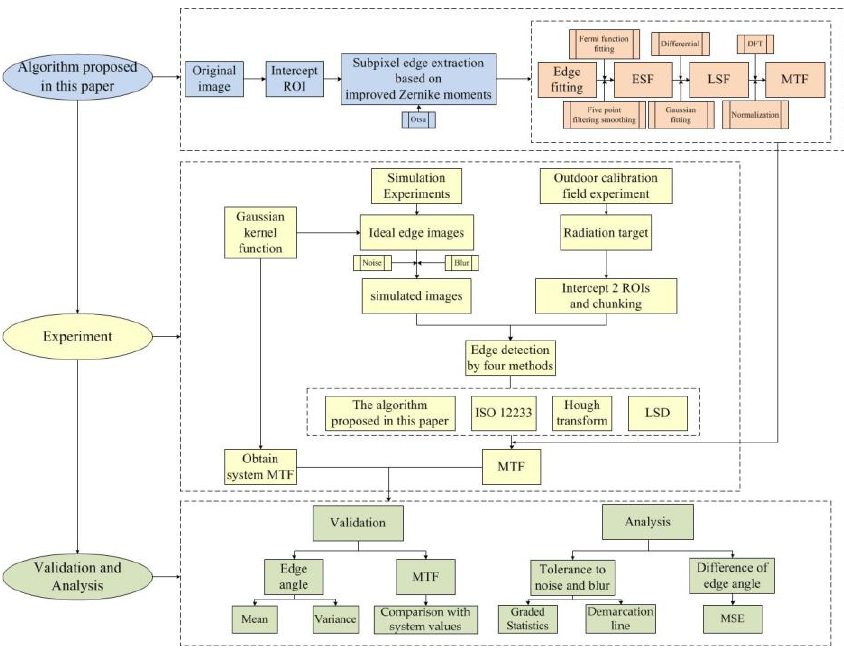
Figure 8. Experimental flow chart.